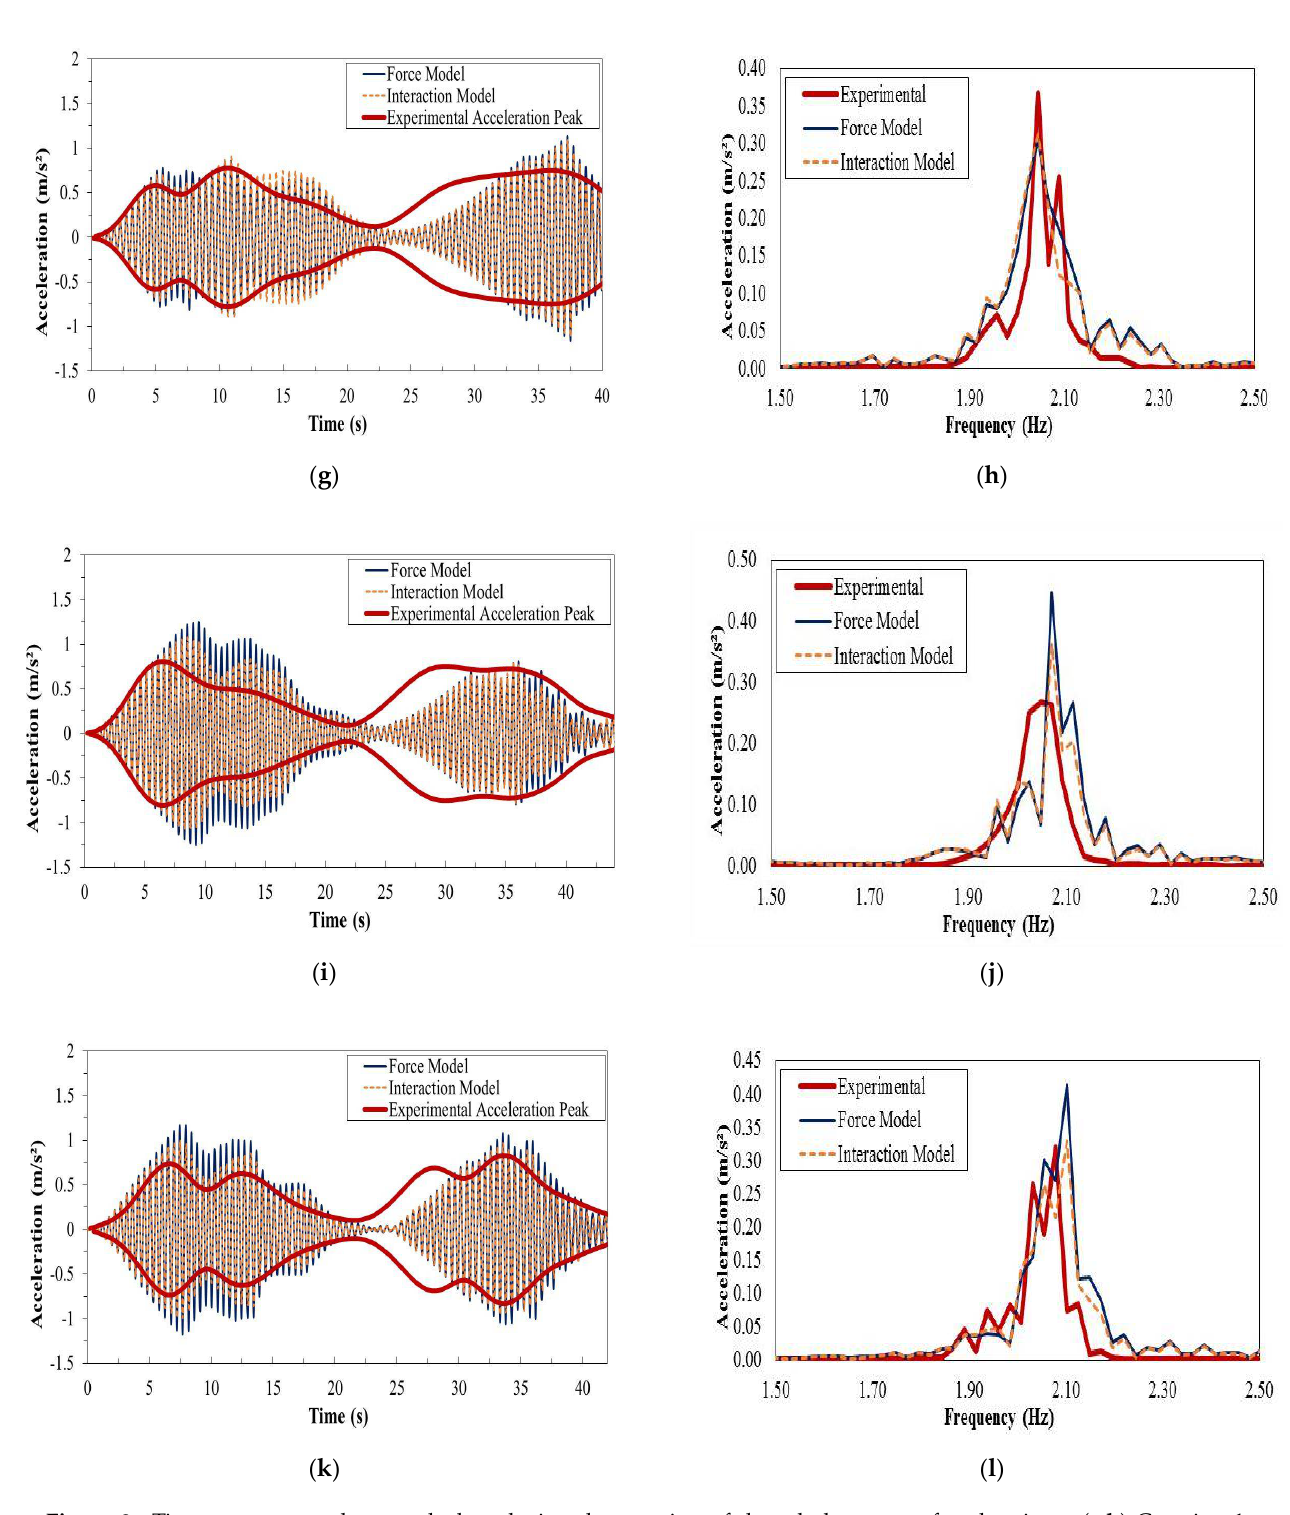
Figure 9. Time response and spectral plots during the crossing of the whole group of pedestrians: ( a , b ) Crossing 1; ( c , d ) Crossing 2; ( e , f ) Crossing 3; ( g , h ) Crossing 5; ( i , j ) Crossing 7; ( k , l ) Crossing 8.